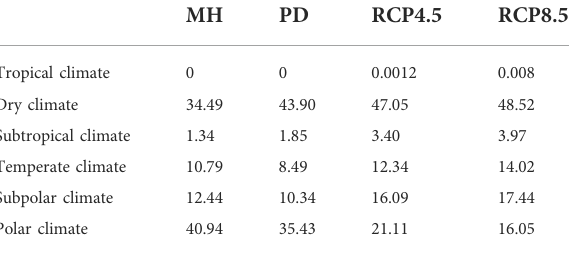
TABLE 2 Areal proportions (%) of the major climate types for selected warm periods.